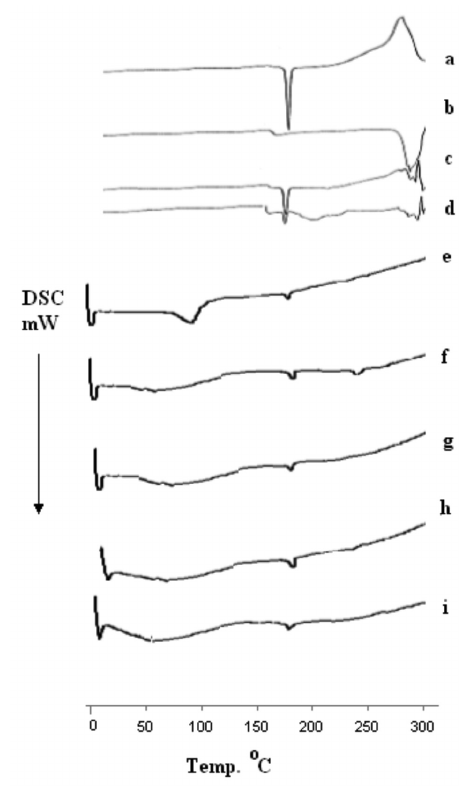
FIGURE 5 - X-Ray Diffraction of pure nifedipine (a); pure β-CD (b); physical mixture (c); coevaporation complex (d); kneading complex (e); cogrounding complex (f); freeze drying complex (g); spray drying complex (h); melting complex (i).